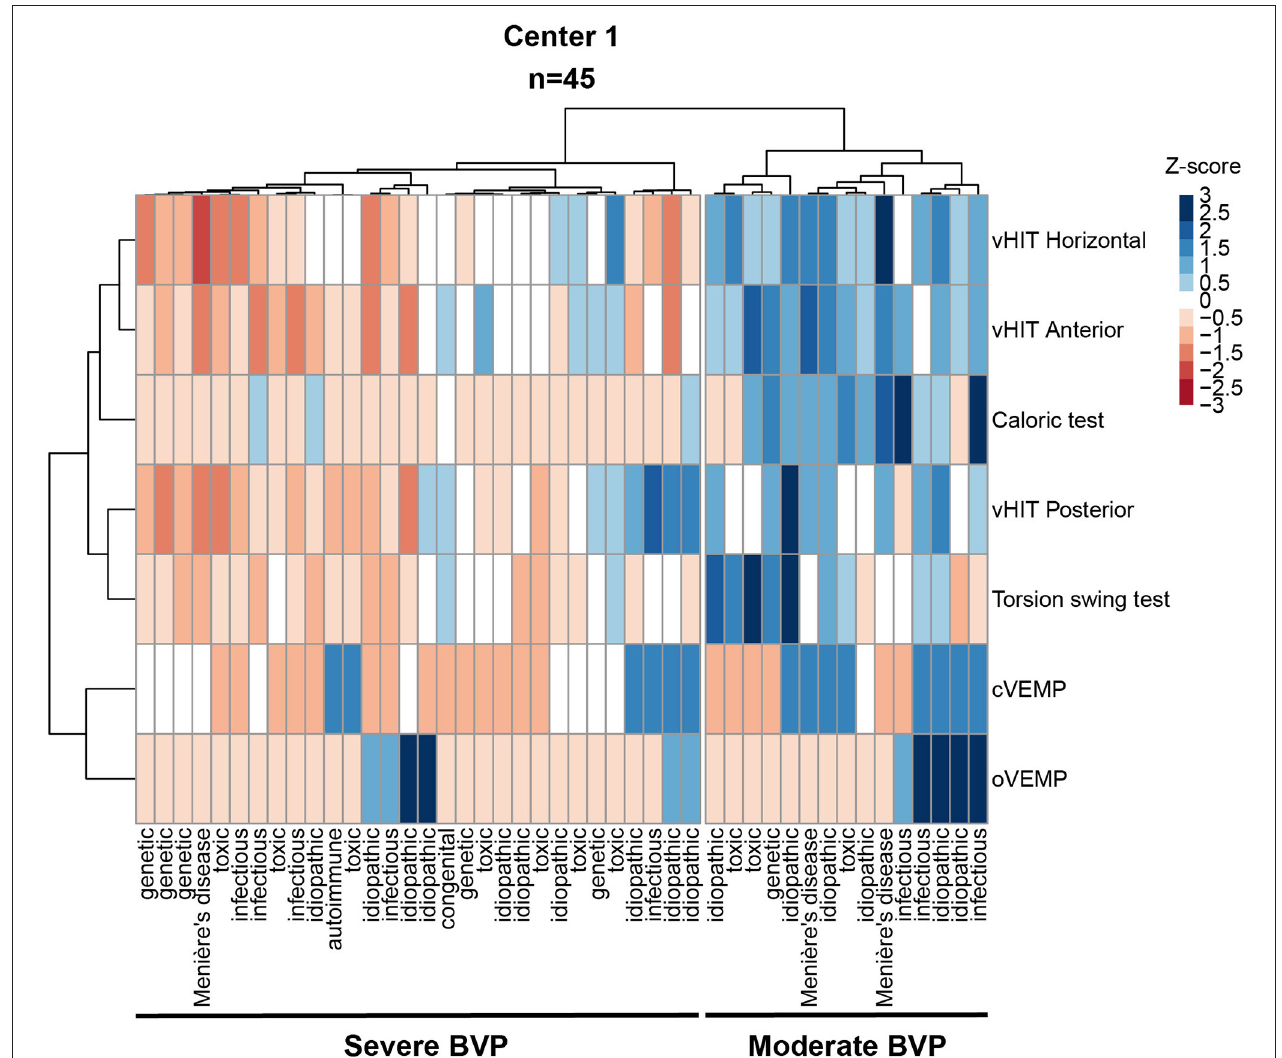
FIGURE 9 | Heatmap as a result of hierarchical cluster analysis with two dendrograms; Each column represents one subject; each row represents the results of a specific vestibular test. A “bad (vestibular) score” (i.e., low scores on tests of vestibular reflexes) is illustrated by lower Z scores in the color red. A “relatively good (vestibular) score” (i.e., relative high scores on tests of vestibular reflexes) is illustrated by higher Z scores in the color blue. Bold underlining indicates the 2 clusters; “Cluster 1, severe BVP” and “Cluster 2, moderate BVP”. Only cases without missing data for caloric testing, torsion swing test, and horizontal and vertical vHIT, and o- and c-VEMPs ( n = 45). vHIT, video Head Impulse Test; oVEMP, ocular Vestibular Evoked Myogenic Potential; cVEMP, cervical Vestibular Evoked Myogenic